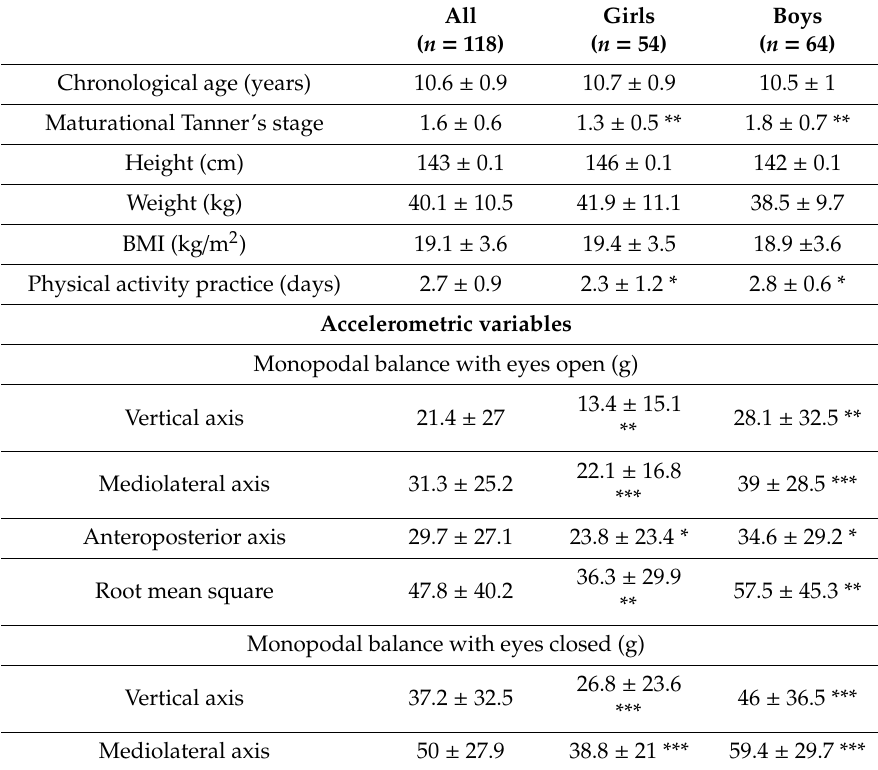
Table 1. Descriptive analysis of the sample (mean ± standard